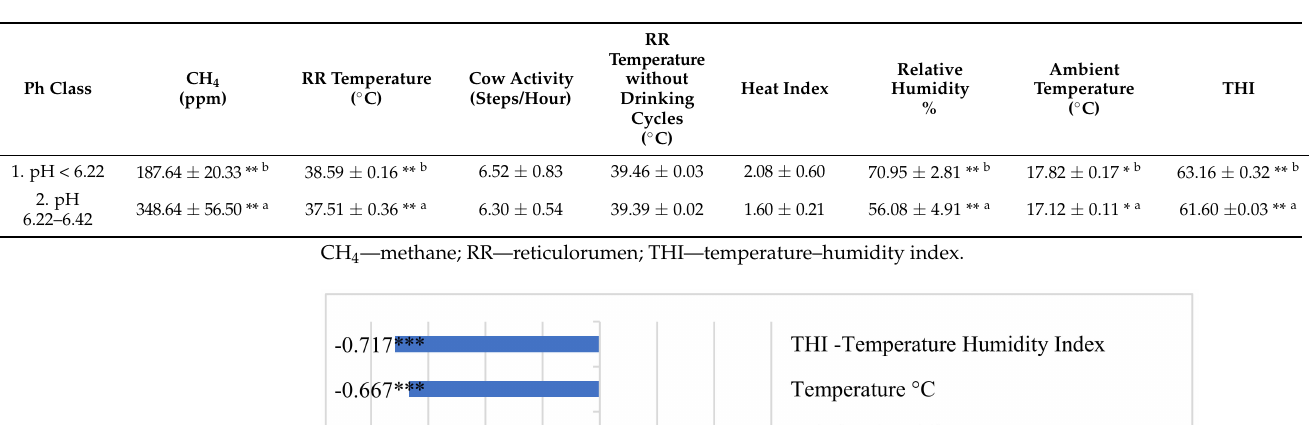
Table 3. Means and standard errors of the investigated indicators based on the reticulorumen pH assay: 1. pH< 6.22 ( n = 25, 69.0% of cows), 2. pH 6.22–6.42 ( n = 11, 31.0% of cows). The letters a,b, represent statistically significant differences between classes. * p < 0.05 , ** p < 0.01.